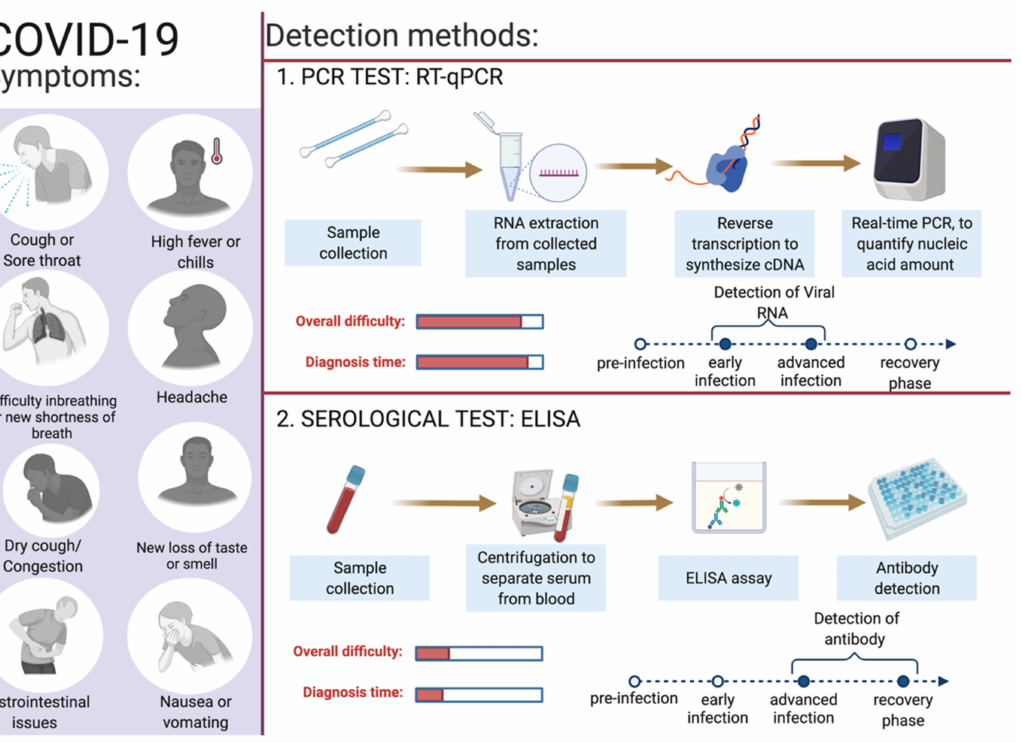
Figure 2. Overview of COVID-19 symptoms and SARS-CoV-2 detection methods for COVID-19 diagnosis. This figure was created with Biorender.com 6 June